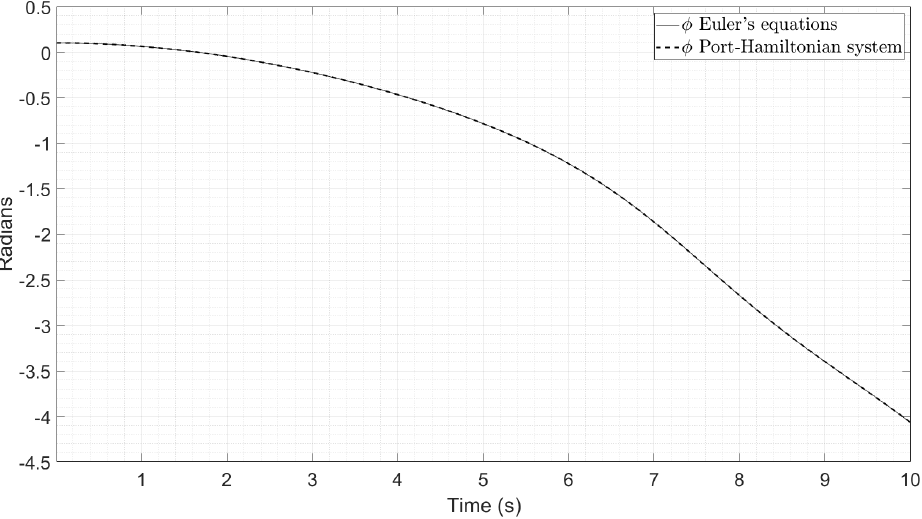
Figure 4. Comparison of the roll angle ( φ ) between the Euler’s equations and the port- Hamiltonian